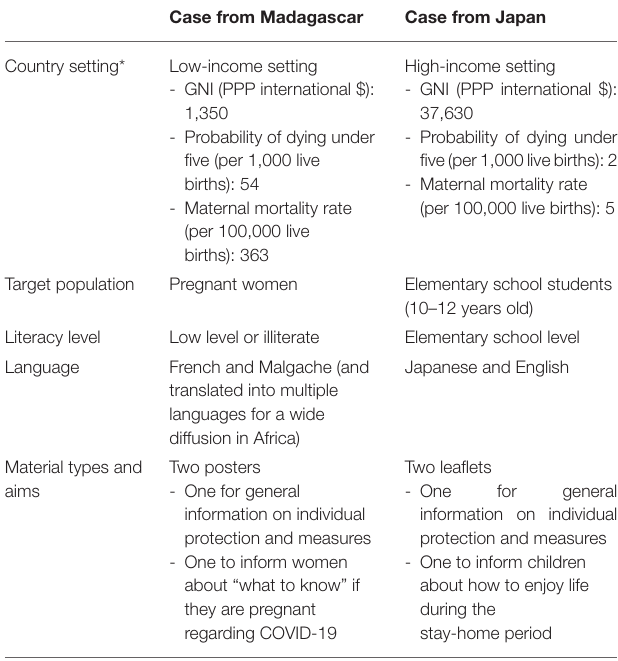
TABLE 1 | Comparison of the two